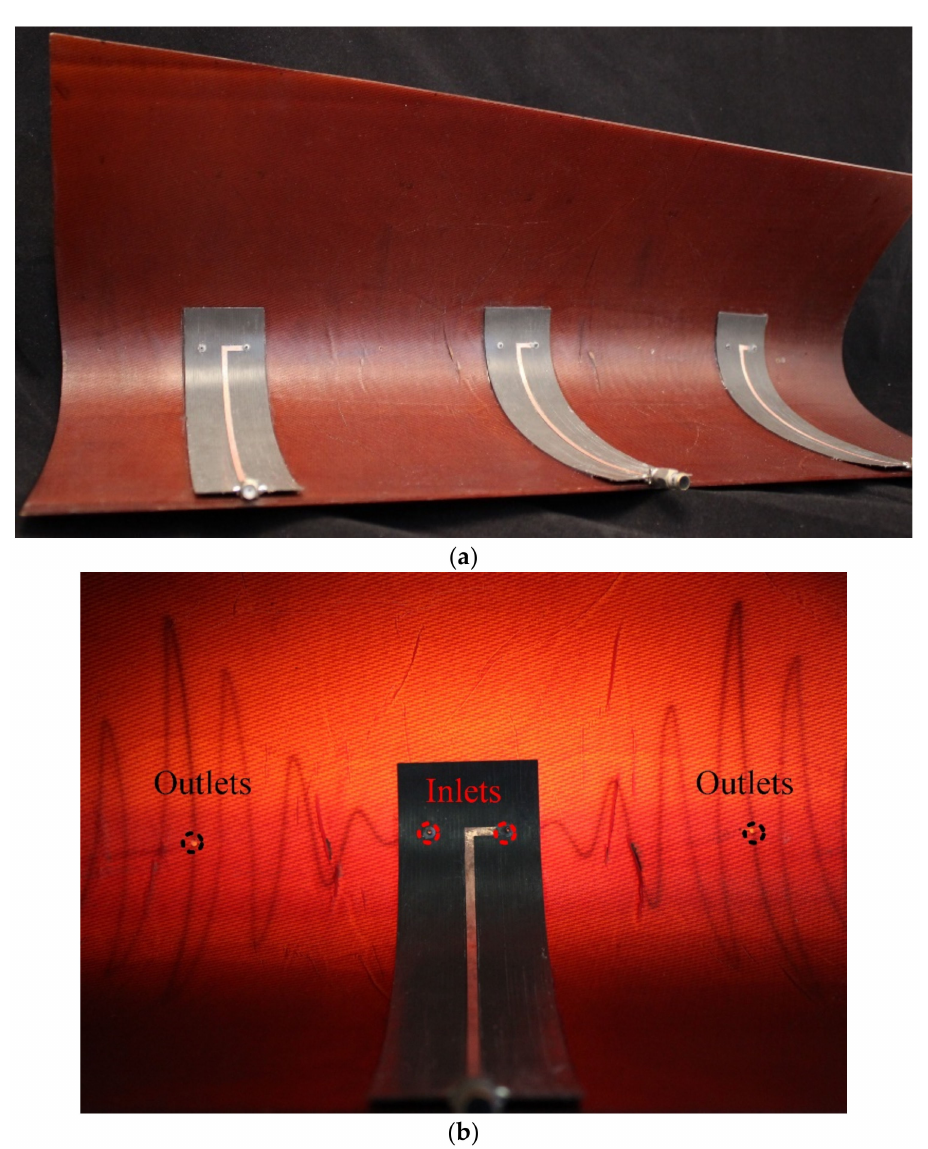
Figure 7. Fabricated model of SEVA-CLA ( a ) Top view showing the complete array with the three elements ( b ) Single element of the array with outlets and inlets